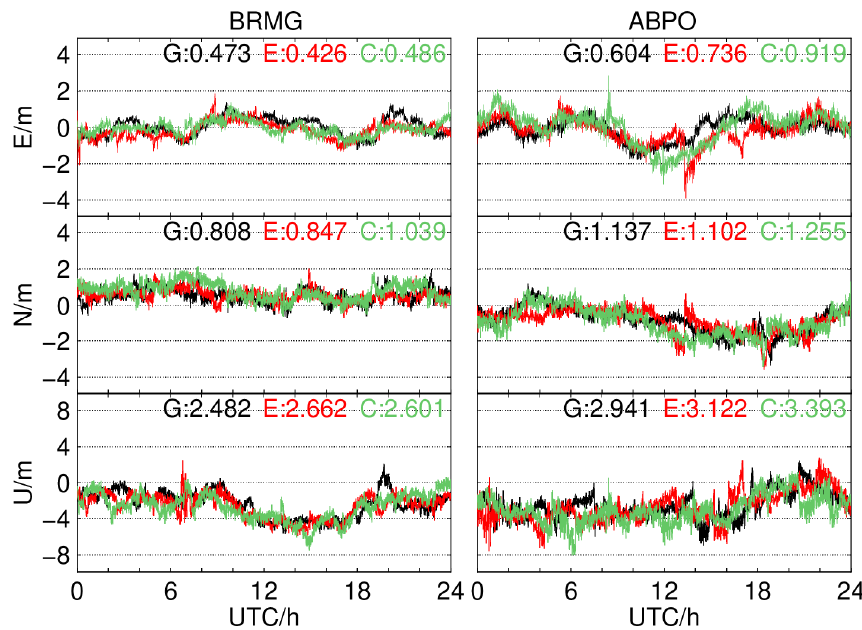
Figure 5. Single-frequency positioning errors for the E, N, and U components of the two tracking stations of BRMG and ABPO.